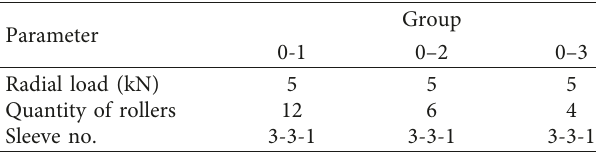
Figure 4: Diagram of the experiment platform for the floating-sleeve bearing. The numbered parts are as follows:1: rotation speed sensor for the floating sleeve, 2: rotation speed sensor for the power input shaft, and 3: radial load sensor. Table 1: Operating parameters in the experiment.